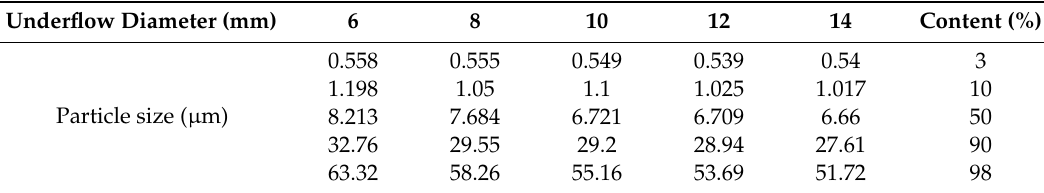
Table 7. Particle size of II underflow.